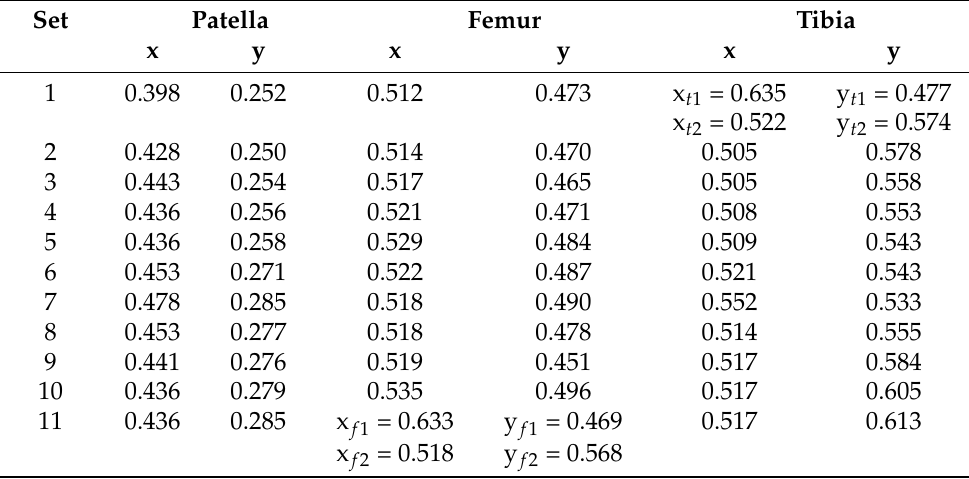
Figure 6. Similarity measures for scan ( a ) no.5 and ( b ) no.8 of the reference series (scans containing the bone structures of the knee joint (1st group) and tested series (2nd group). Table 1. Normalized values of the x and y coordinates of the centroid due to the size of the slice on the transverse